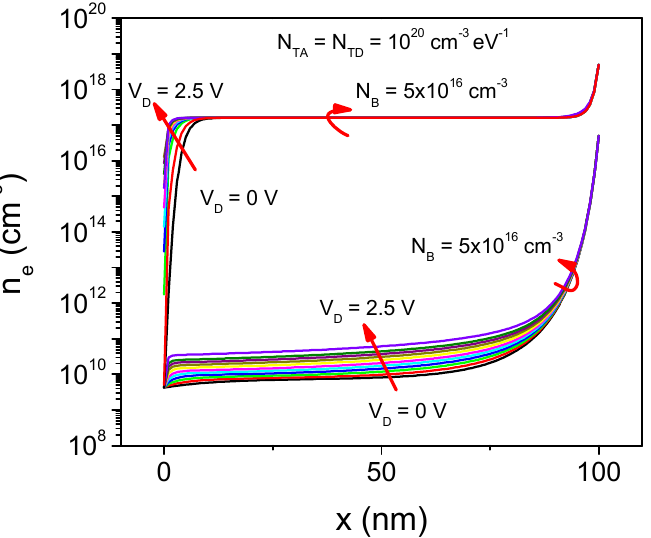
Figure 7. Comparison of the electron concentration ( n e ) vs. the semiconductor film position (x), for both N B values used in the simulations.